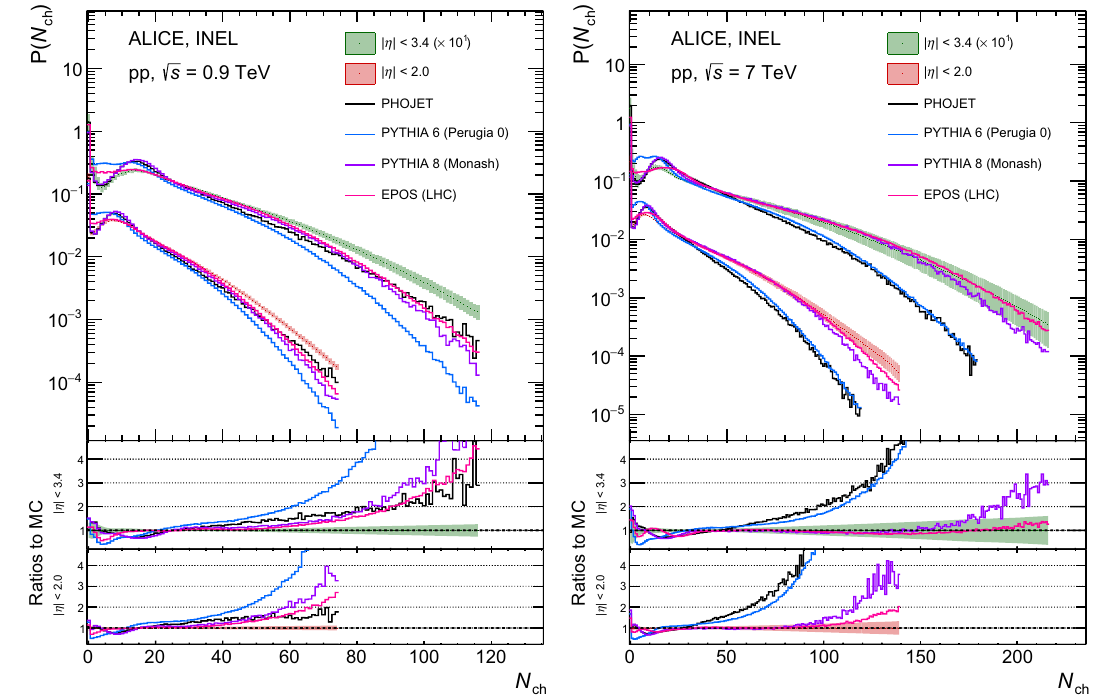
Fig. 6 Comparison of the multiplicity distributions for NSD pp collisions at in the same pseudorapidity ranges and previous ALICE measurements [4]. Combined systematic and statistical uncertainties are shown as bands